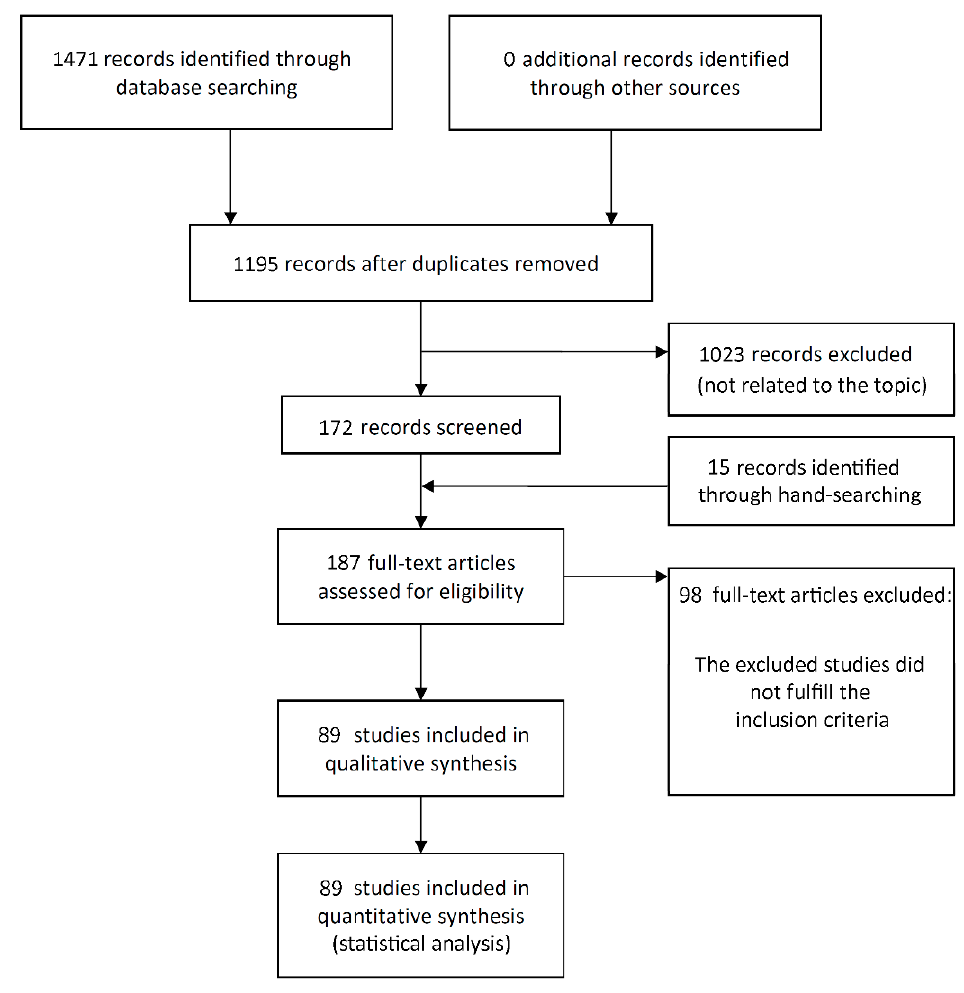
Figure 1. Study screening process.